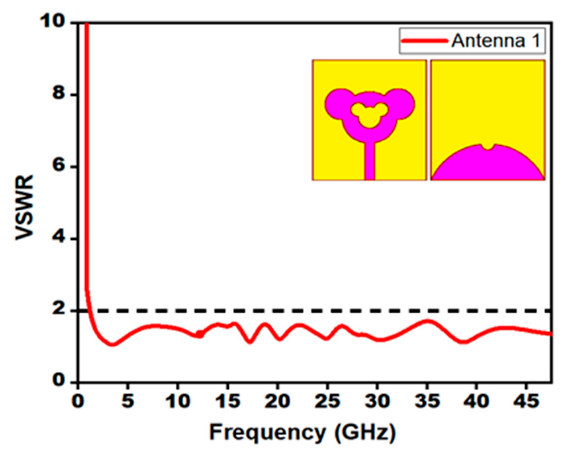
Figure 2. Phase 1: VSWR result of the SWB antenna.